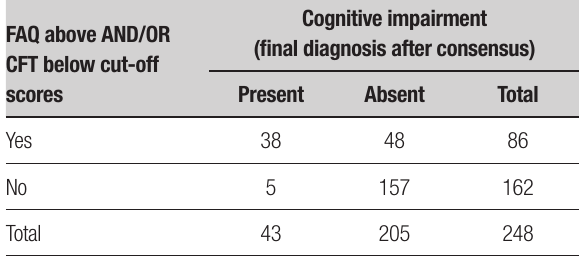
Table 4. Functional Activities Questionnaire (FAQ) and category fluency